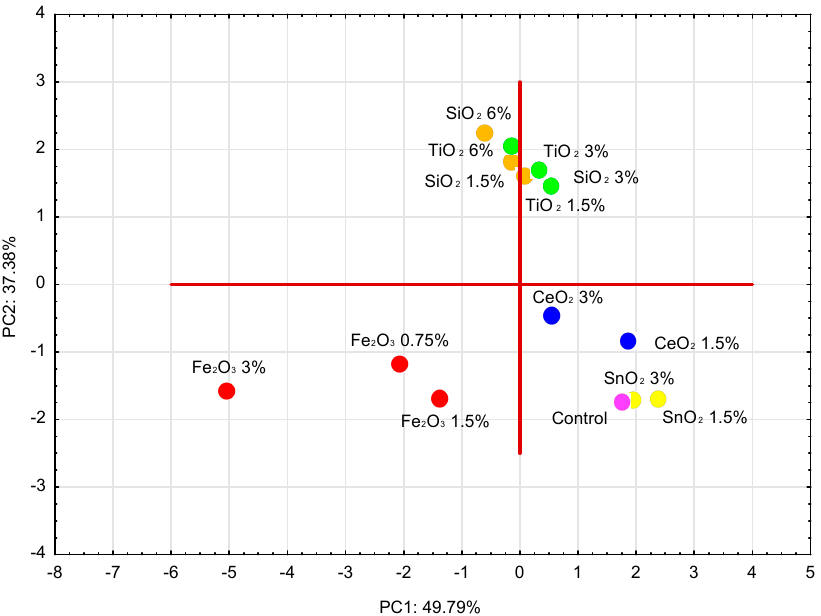
Figure 4. Results of principal component analysis (PCA) analysis for experimental treatments